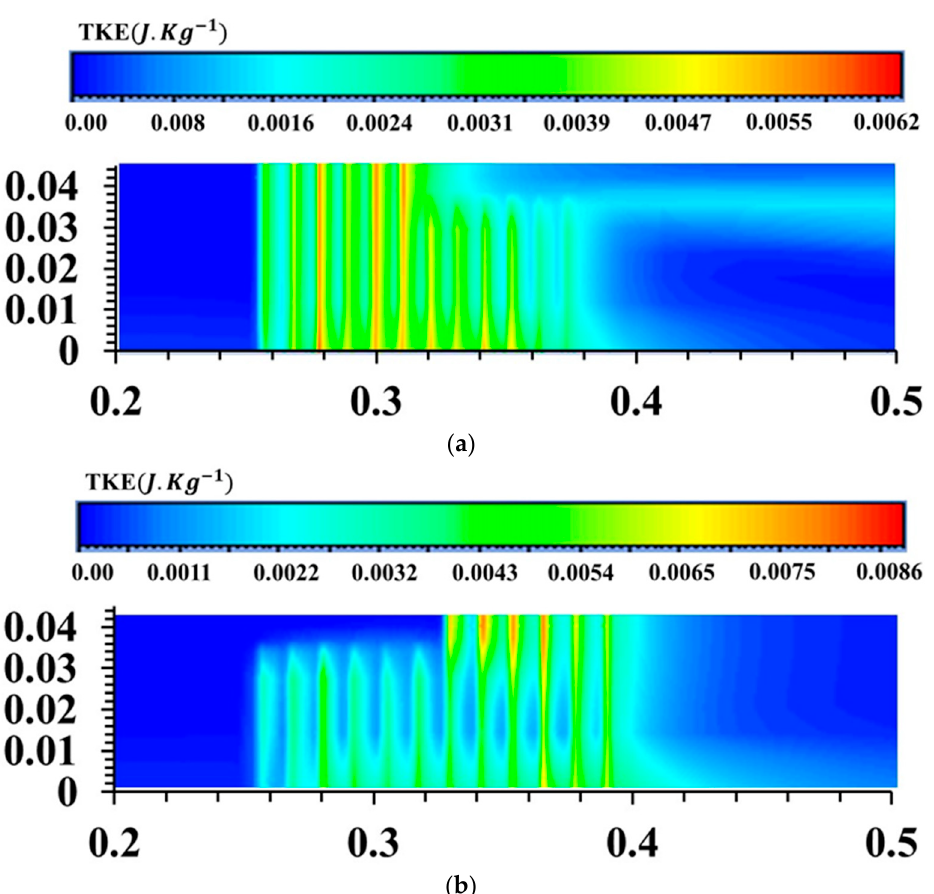
Figure 12. Longitudinal contour plot distribution of turbulence kinetic energy (TKE): ( a ) case 1; ( b ) case 3.